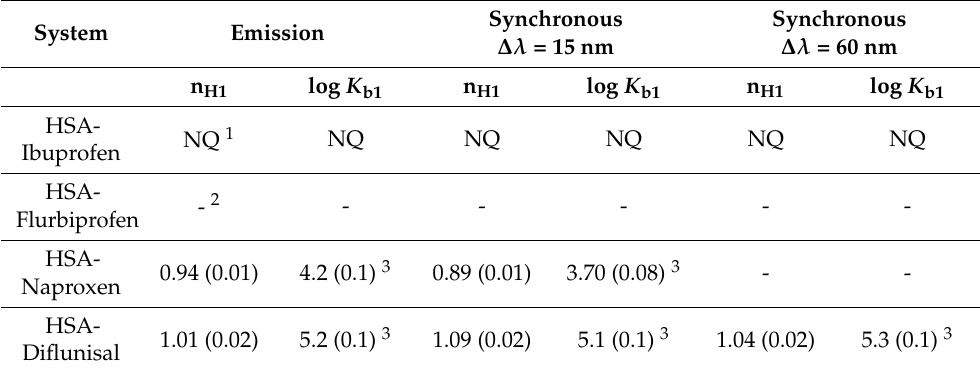
Table 2. Stoichiometry and binding constants obtained at 25 ◦ C using the DLSV approach for data at three different fluorescence modes.